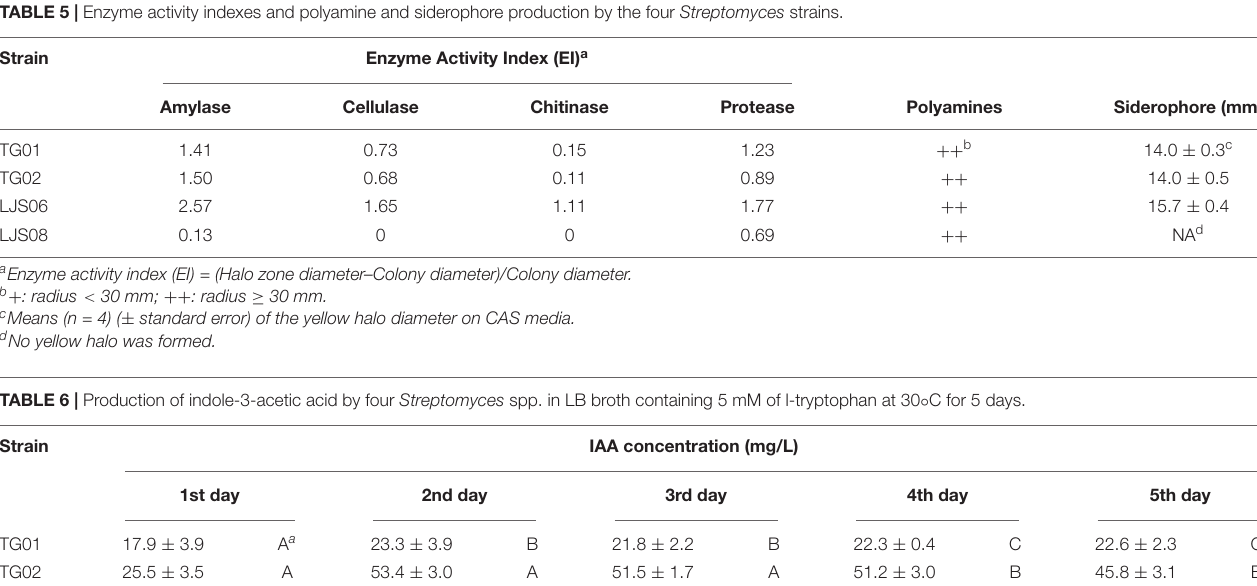
TABLE 7 | Effect of Streptomyces griseorubiginosus LJS06 culture filtrate (SL06) on conidial germination and appressorium formation of Colletotrichum orbiculare . Treatment Conidial germination (%)